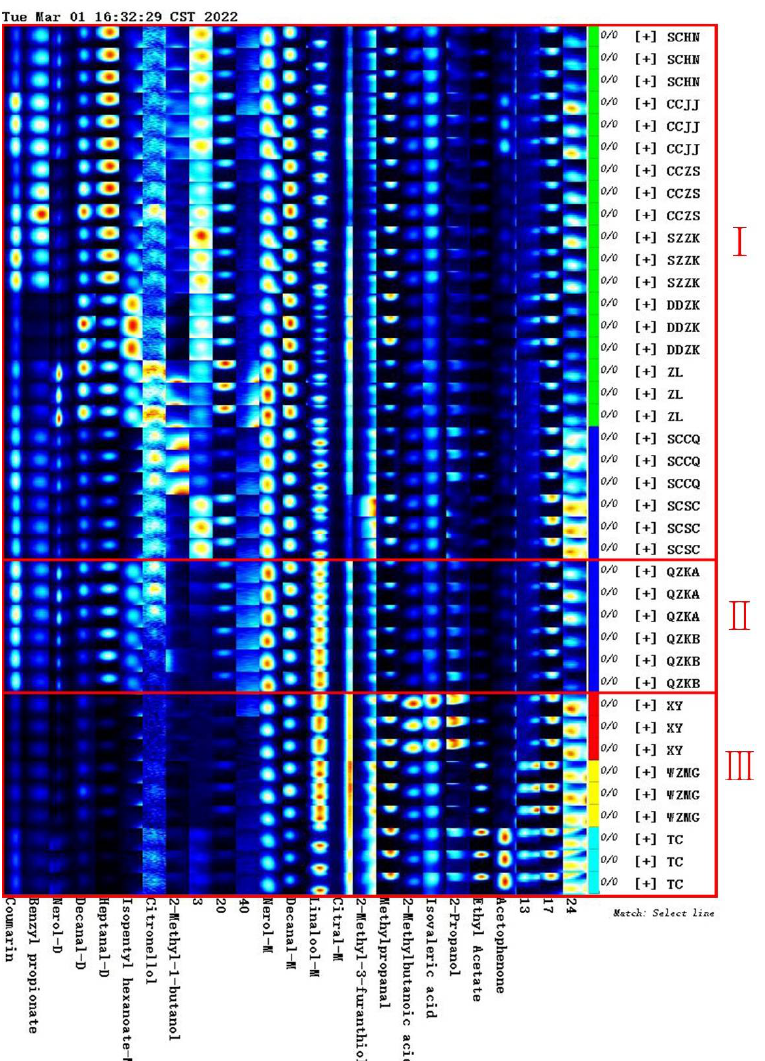
Figure 8. Fingerprint of characteristic components of Qu Aurantii Fructus. Note: each row represents sample data (from top to bottom: region I: Aurantii Fructus; region II: Qu Aurantii Fructus; region III: adulterants); each column represents a compound.